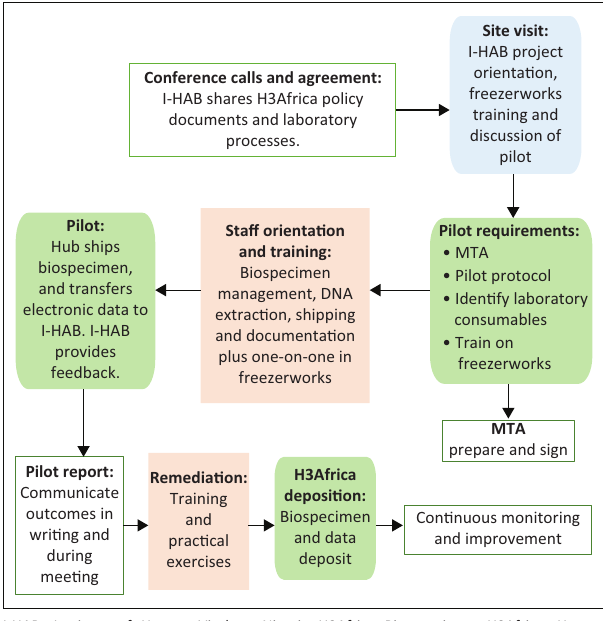
Lab, laboratory. FIGURE 2: Project A’s training scores in Nigeria March 2015. Project A’s pre-test and post-test training scores according to staff designation. Two persons were absent during the pre-test; thus, those scores are